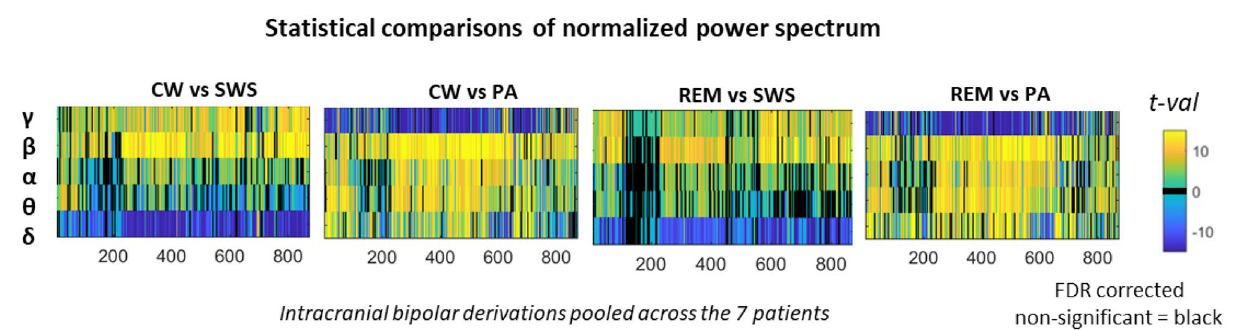
Figure 5. Statistical comparison of power spectrum analysis across the five frequency band of all the bipolar derivation of the patients of the second